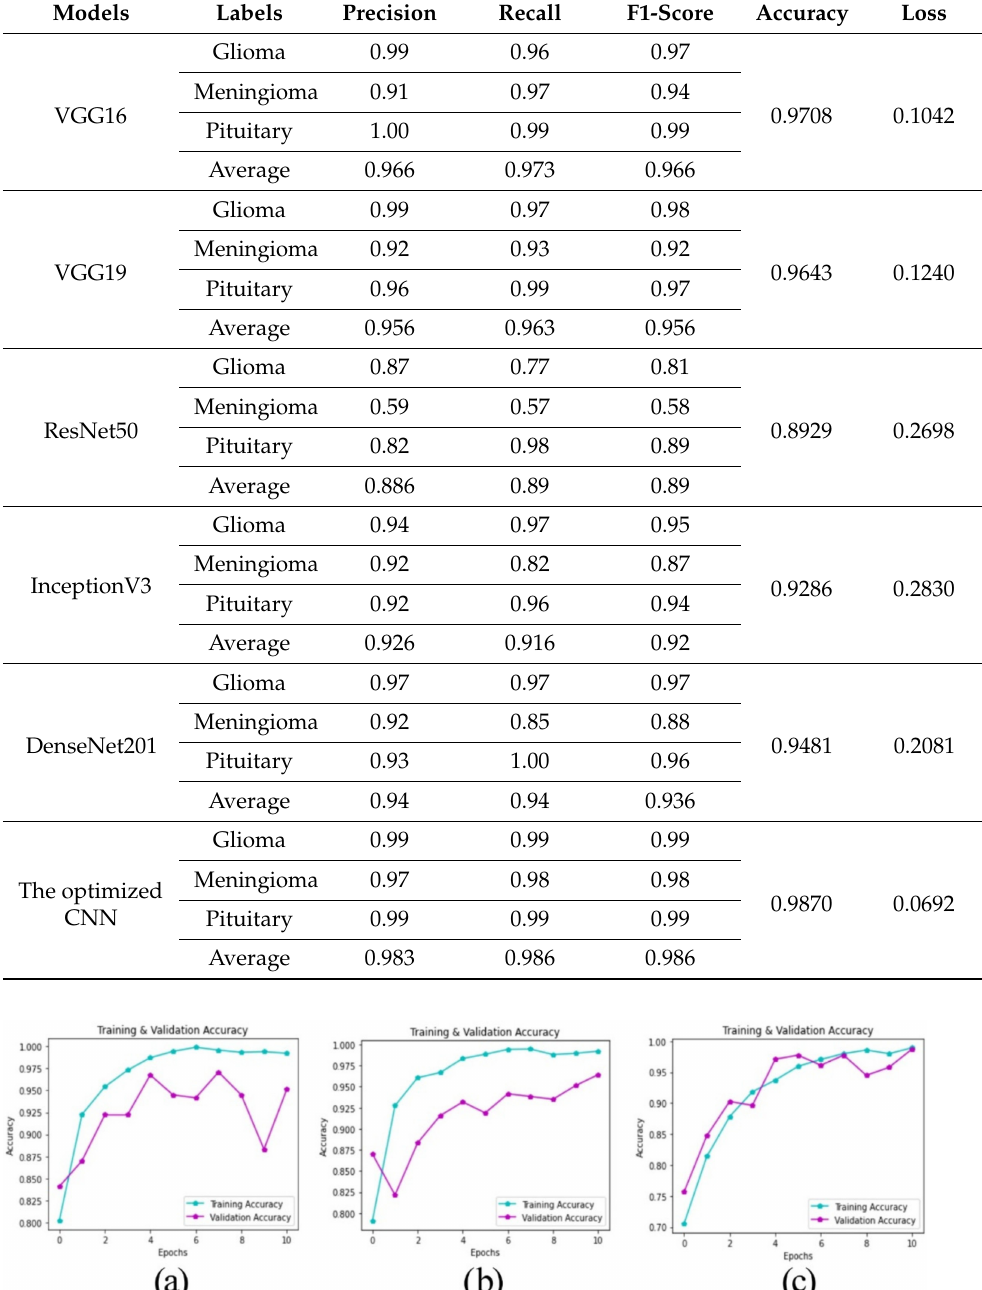
Table 8. Comparative results based on precision, recall, F1-score, accuracy, and loss.